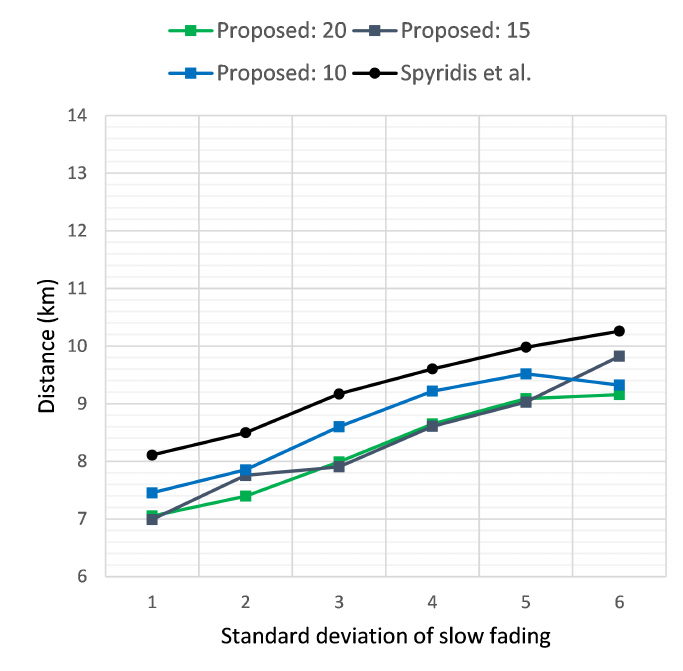
Figure 7. Average distance covered per UAV when the target sensor is placed at a distance of 2 km, versus the standard deviation σ of the additive noise. Comparison of the proposed method at clustering termination thresholds of 20, 15 and 10 dB and the previous approach.